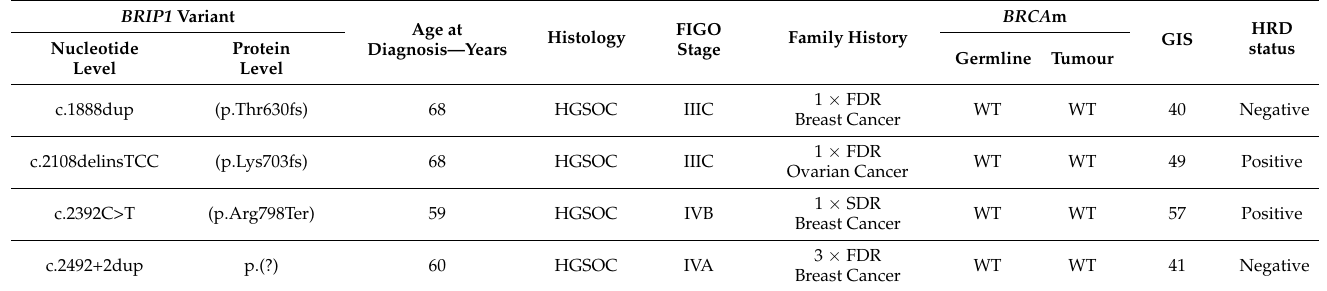
Table 6. Demographic data for patients diagnosed with a germline BRIP1 pathogenic variant. Key: BRCA m, BRCA1/2 pathogenic variant; FDR, first-degree relative; GIS, genomic instability